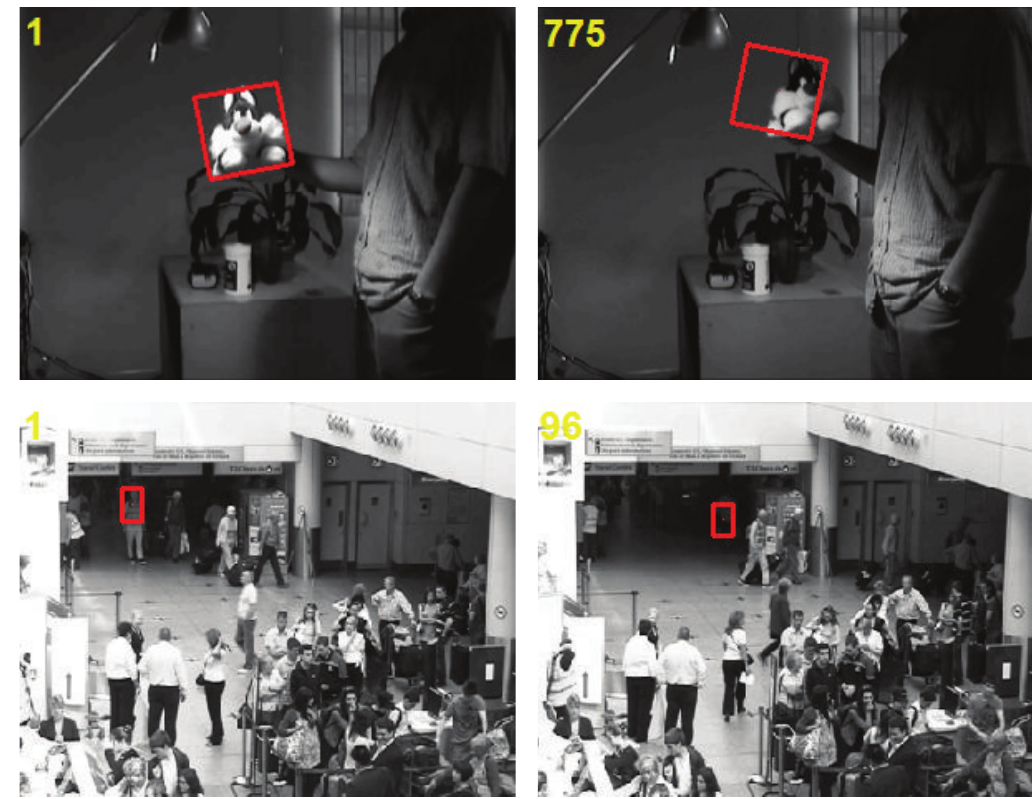
Figure 1: Two cases for the IVT tracker